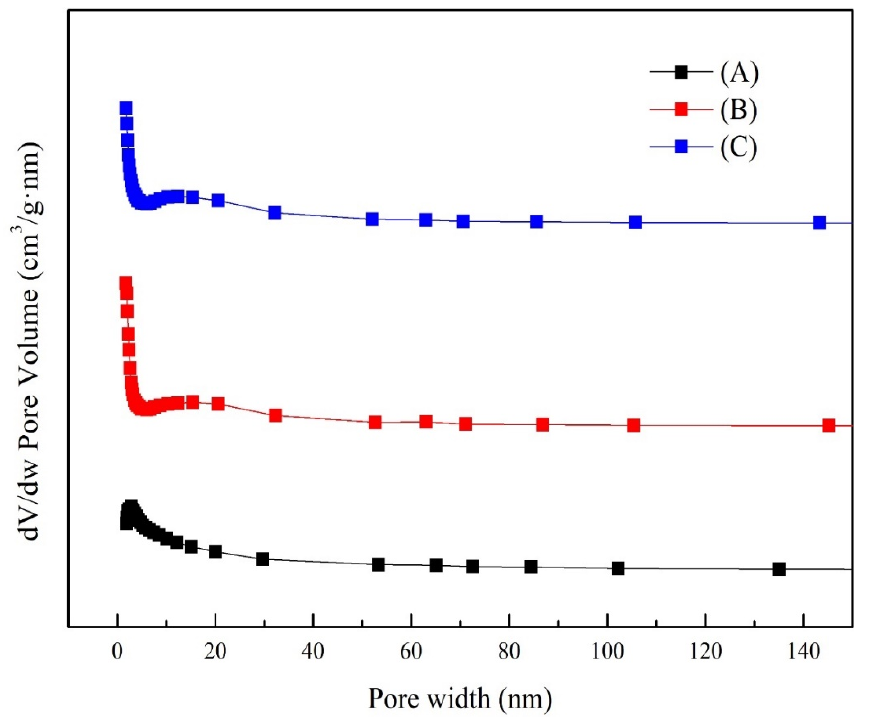
Figure 4. Pore distribution of BFSZ synthesized at crystallization times of ( A ) 4 h ( B ) 6 h and ( C ) 8 h. Table 3. Microstructural characteristics results of the BFSZ prepared at various crystallization times Crystallization Time (h)